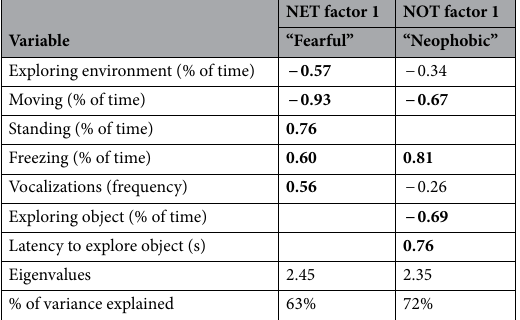
Table 3. Loadings of the factors with an eigenvalue above one that were extracted by factor analysis with orthogonal varimax rotation on the behaviours and postures scored during the novel environment test (NET) and the novel object test (NOT). High loadings (loadings ≤ − 0.5 or ≥ 0.5) are indicated in